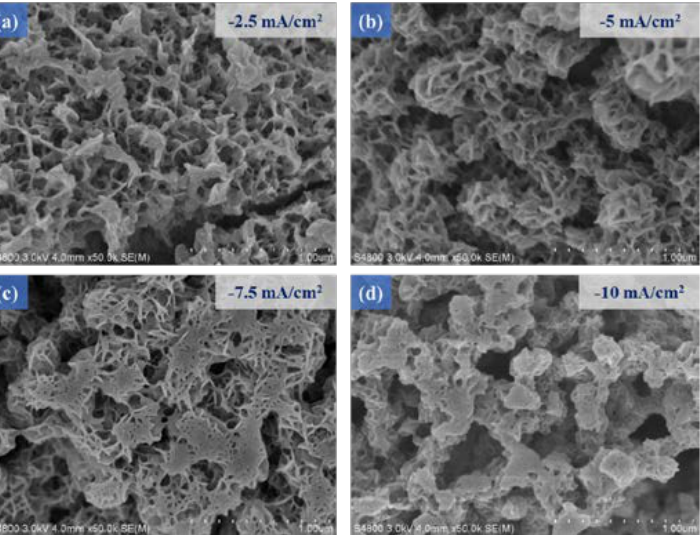
Figure 3. The MnS/MoS 2 thin films were prepared by electrodeposition with the current densities of ( a ) −2 .5 mA/cm 2 , ( b ) −5 mA/cm 2 , ( c ) −7 .5 mA/cm 2 , ( d ) −1 0 mA/cm 2 , respectively.